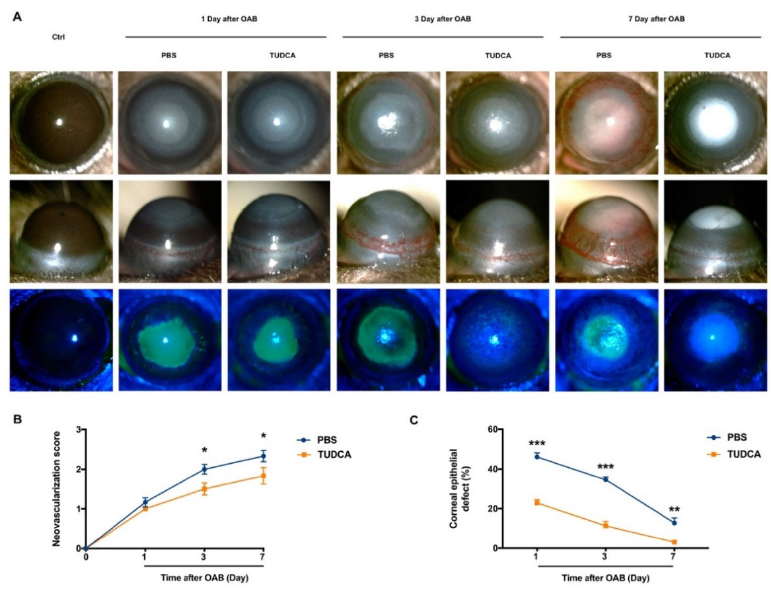
Figure 1. TUDCA ameliorates CNV and promotes corneal re ‐ epithelization after OAB. ( A ) Macro ‐ scopic and fluorescein sodium ‐ stained images of control and alkali ‐ burned eyes were taken 1, 3, and 7 days post ‐ injury. ( B ) The scores of CNV in alkali injury eyes treated with PBS or TUDCA at dif ‐ ferent times. ( C ) Quantitative analysis of corneal epithelial defect area in the PBS ‐ treated group and TUDCA ‐ treated group at different times after OAB. The percentage of epithelial defect area is the area of sodium fluorescein staining in each eye compared to the area of the entire cornea. Data are expressed as mean ± SEM ( n = 12 mice/group, * p < 0.05, ** p < 0.01, *** p < 0.001). Ctrl, control; OAB, ocular alkali burn; TUDCA, tauroursodeoxycholic acid; CNV, corneal neovascularization. A histological analysis of the cornea revealed a progressive increase in the number of corneal stromal cells after the OAB (Figure 2A). The TUDCA treatment significantly reduced the number of corneal stromal cells on day 3 and day 7 after the OAB compared to the PBS treatment (97.66 ± 15.07 cells/field versus 237.83 ± 53.71 cells/field on day 3, p = 0.03 ; and 80.66 ± 13.68 cells/field versus 302.0 ± 46.20 cells/field on day 7, p < 0.001, Figure 2B). To analyze the corneal inflammation triggered by the OAB, we evaluated the CD45 +